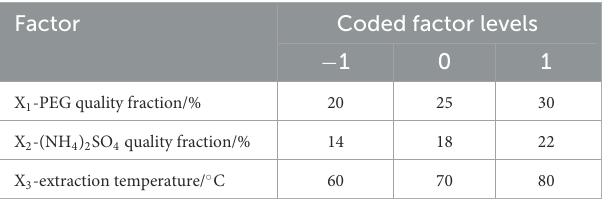
TABLE 1 The process parameters setting for ALPs extraction, according to Box–Benkhen design. Factor Coded factor